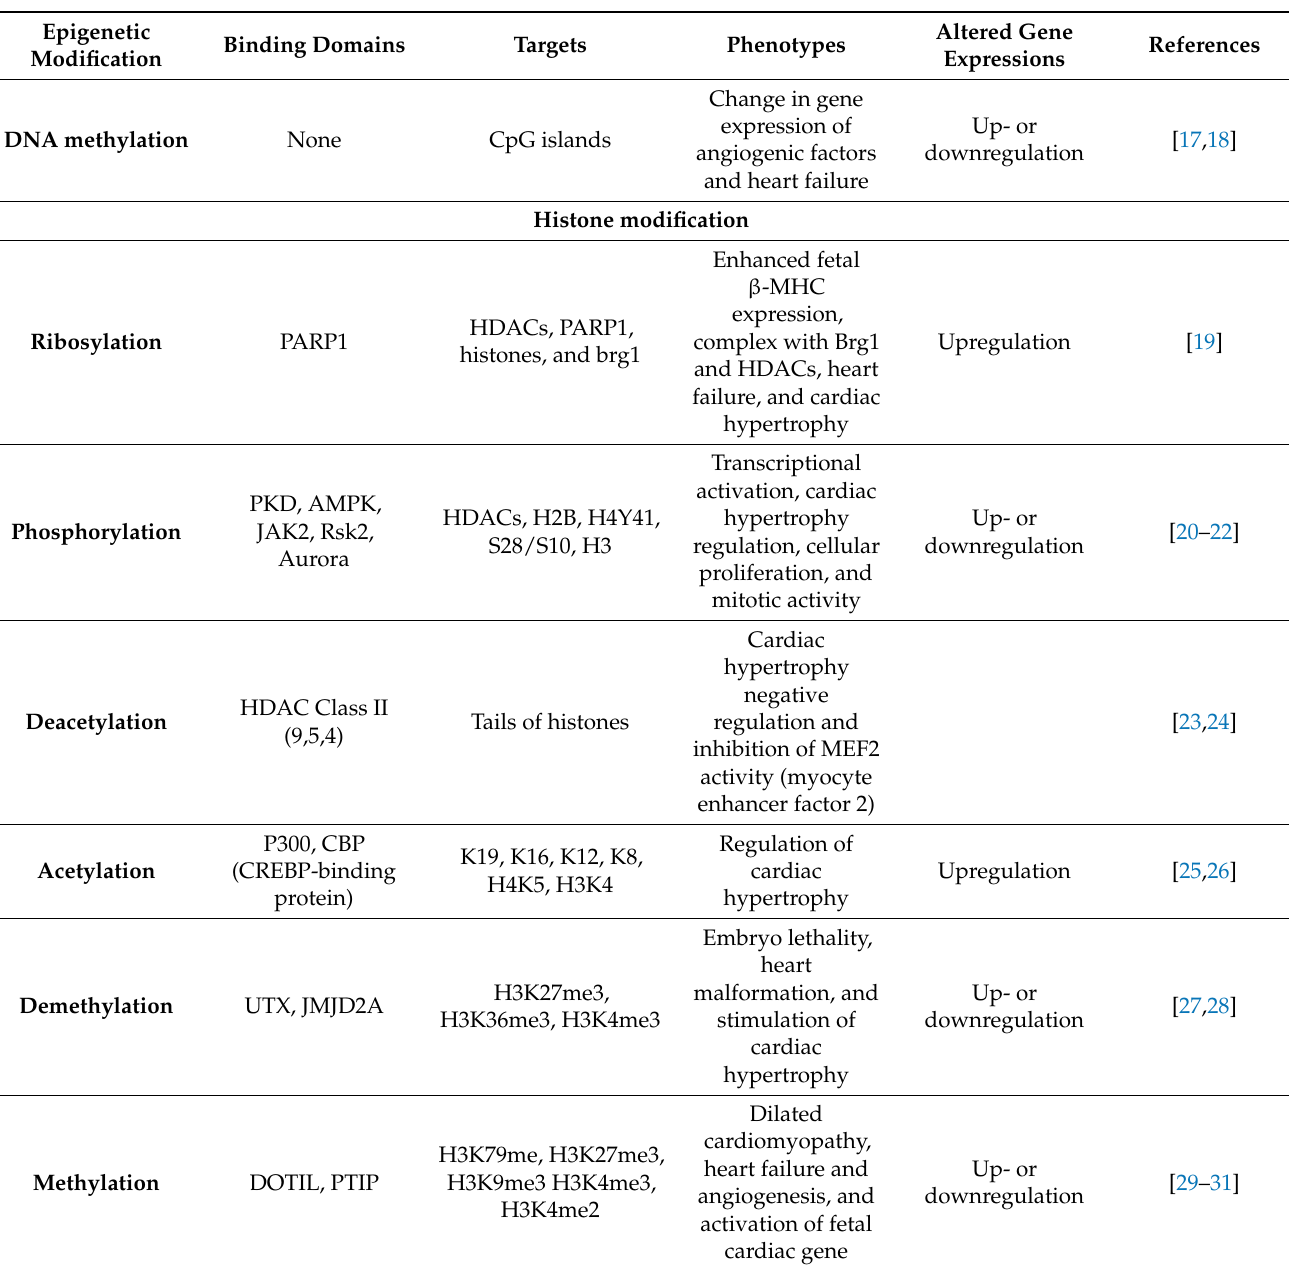
Table 1. Role of epigenetic modifications: DNA methylation and histone